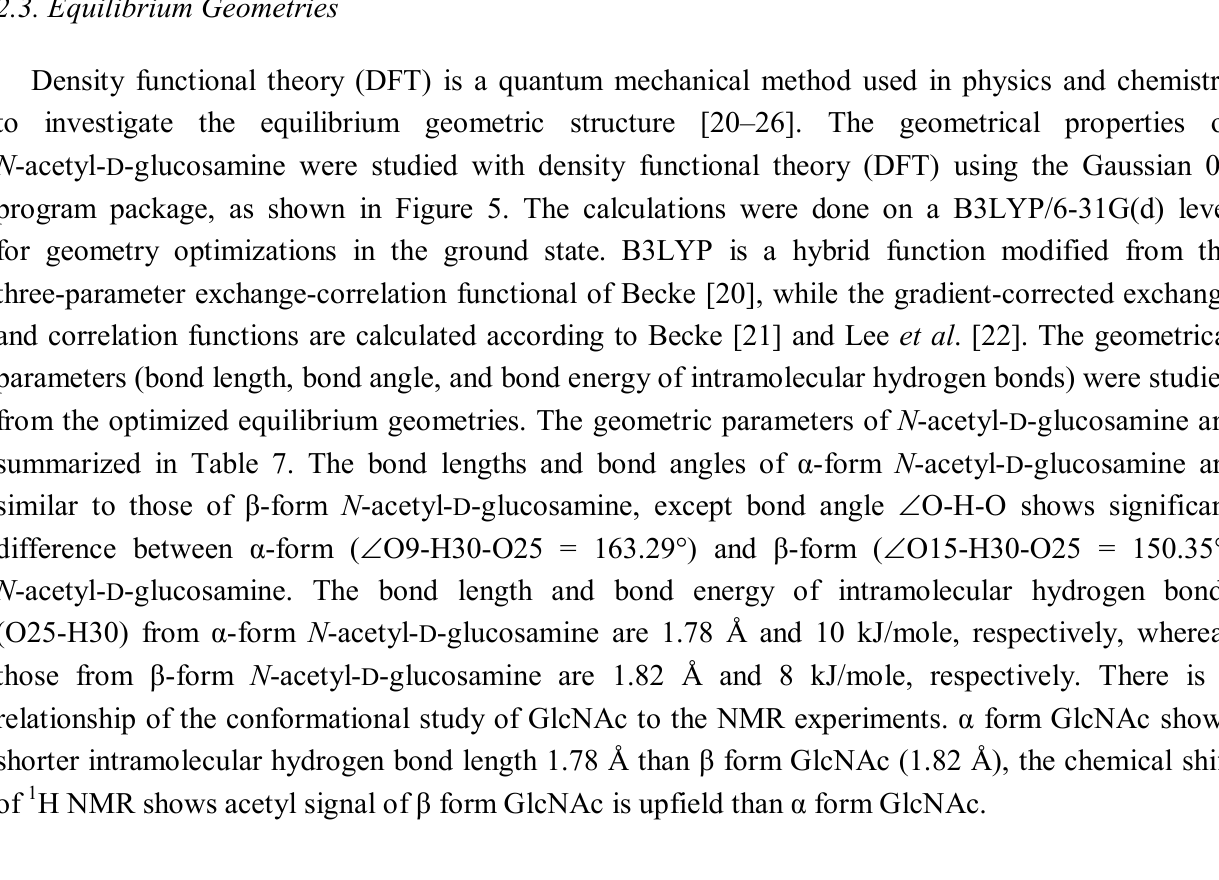
Table 6. Fitting parameters of kinetic constants ( k ) for (GlcNAc) and (GlcNAc) temperatures ( k = a